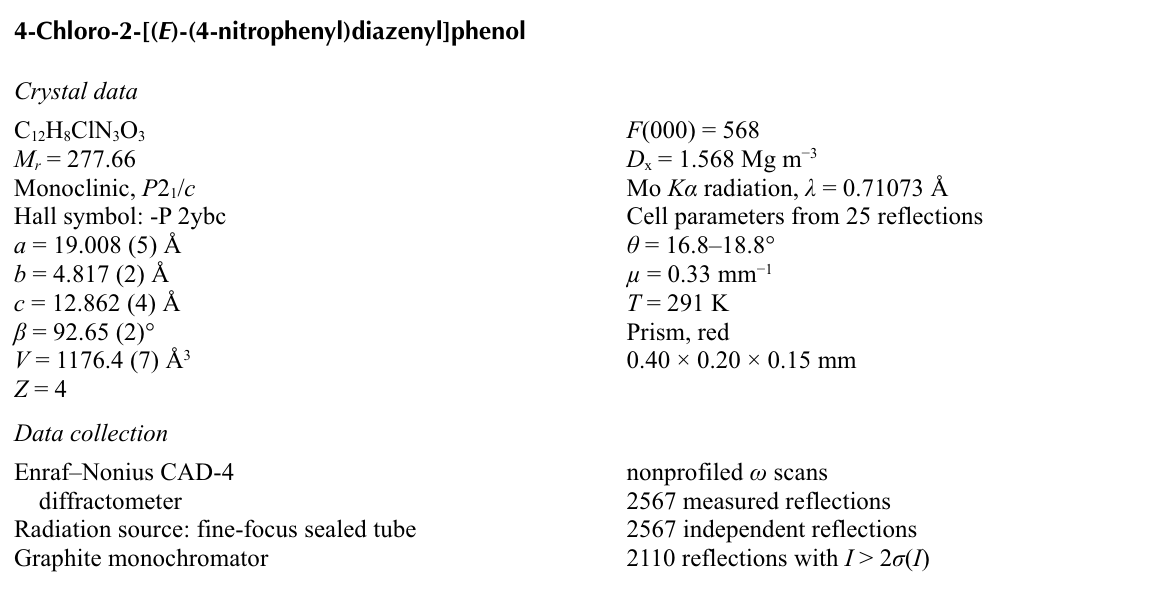
Chemical diagrams of (II) and